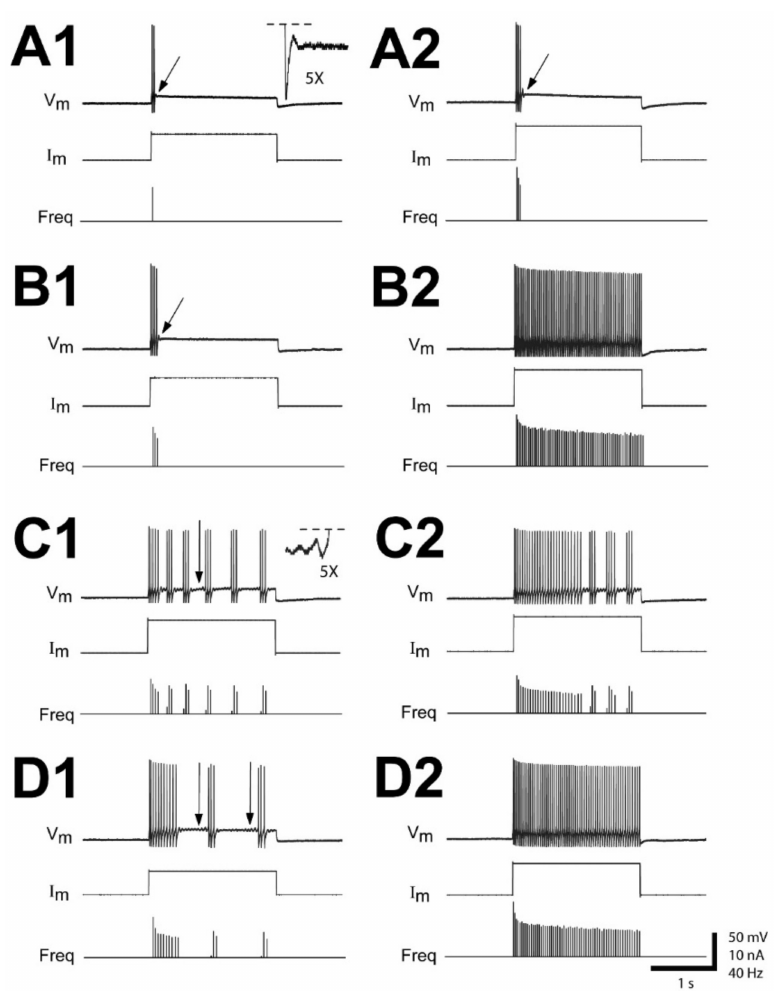
Figure 4. Variations in repetitive firing patterns with injected current levels. Recordings from injured (right) RS neurons in different animals at 2–3 wks following right spinal cord HTs at 10% BL (see Figure 1B). ( A ) Right “B3” neuron and ( B ) right “M3” neuron (see Figure 1A) that ( A1,B1 ) initially fired a single burst in response to intermediate depolarizing current levels (see text), and at higher currents either ( A2 ) continued to fire a single burst or ( B2 ) fired continuously. Inset (5 × enlargement) and arrows indicate “resonance”, which in this case was manifested by damped V m oscillations following a single burst. ( C ) Right “I1” neuron and ( D ) right “B1” neuron that ( C1,D1 ) initially fired multiple short bursts in response to intermediate depolarizing current levels (see text), and at higher currents either ( C2 ) continued to fire multiple bursts or ( D2 ) fired continuously. Inset (5 × en- largement) and arrows indicate “resonance”, which in this case was manifested by progressively increasing V m oscillations between multiple bursts. Horizontal dashed lines indicate truncated